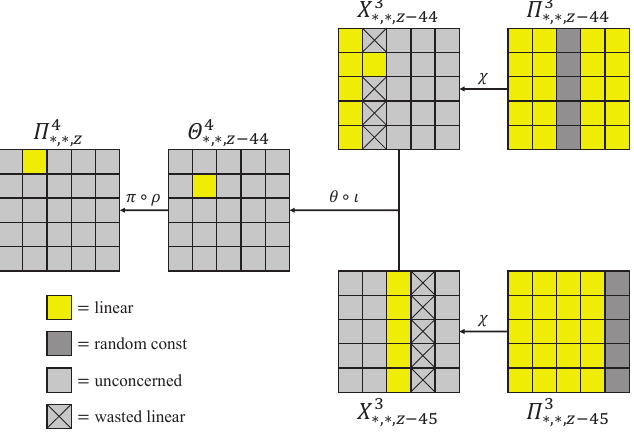
Figure 5: Control a single bit by spending 11 degrees of